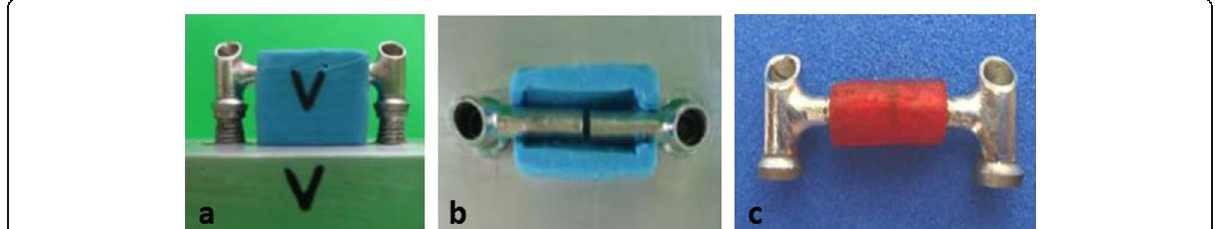
Fig. 2 a , b Silicon model to standardize resin volume. c IFPD indexed with acrylic